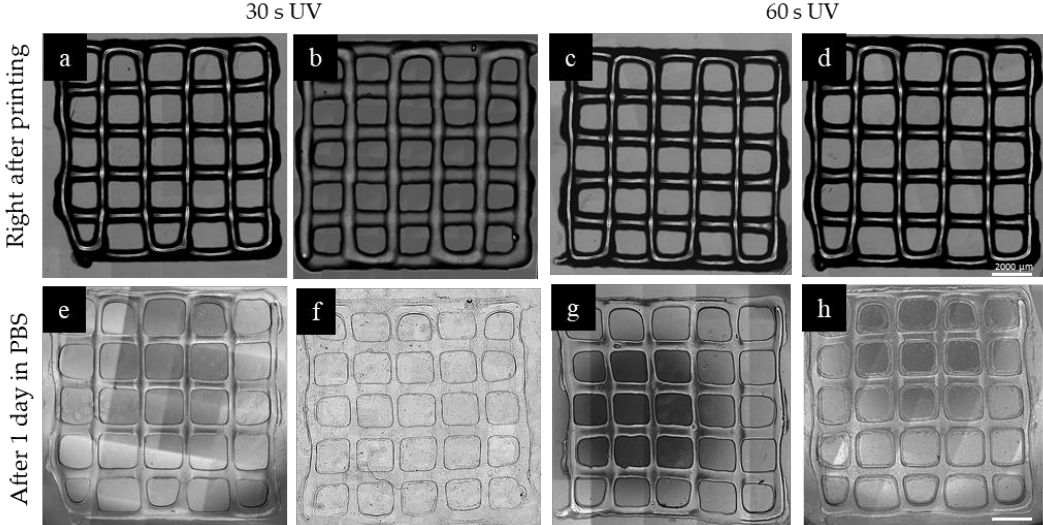
Figure 5. 3D printed constructs made of 2 layers, prepared using ( a , b , e ) 30 s of UV crosslinking without mTGase treatment, ( f ) 30 s of UV crosslinking with 30 min mTGase treatment, ( c , d , g ) 60 s of UV crosslinking without mTGase treatment, ( h ) 60 s of UV crosslinking with 30 min mTGase treatment. The treatment with mTGase reduced the swelling and helped the structure to preserve its shape. (Scale shows 2000 µ m)